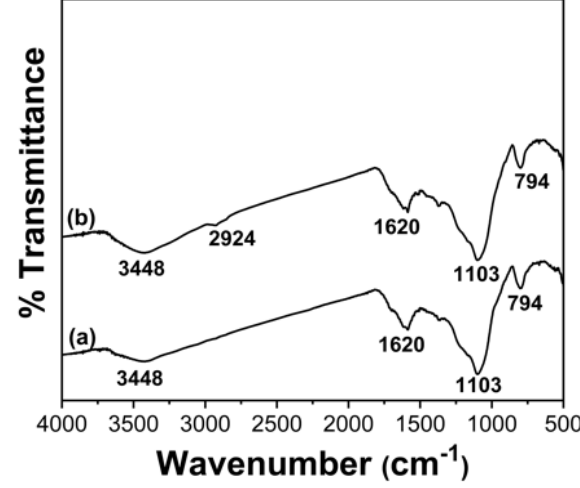
Table 1. Morphological properties of RH and BC using BET surface area